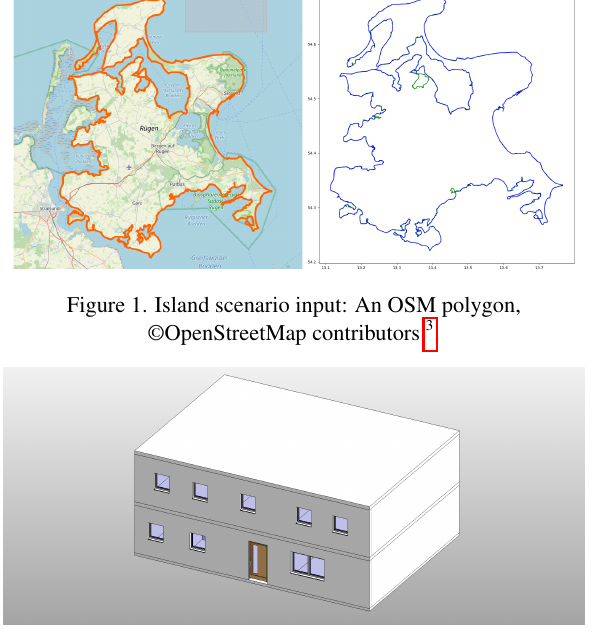
Figure 2. Building scenario input: A Revit 3D building